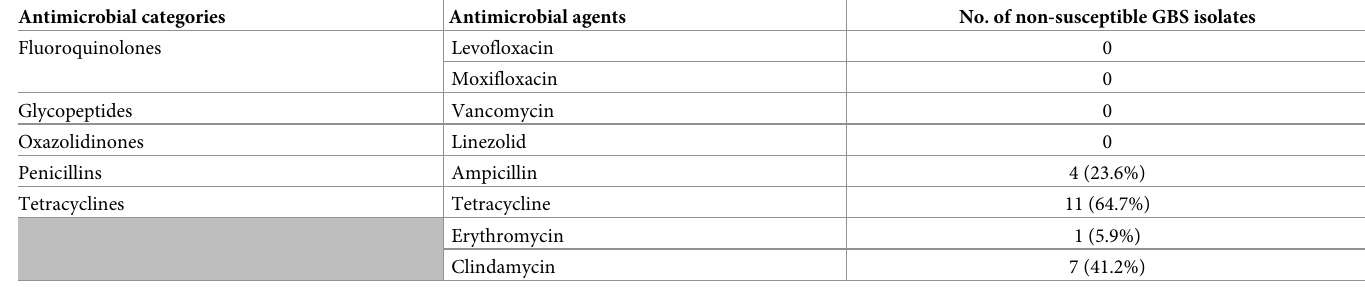
Table 5. Antimicrobial resistance of 17 group B Streptococcus according to the categories and definitions for Enterococcus spp by Magiorakos et al. [22]. Antimicrobial